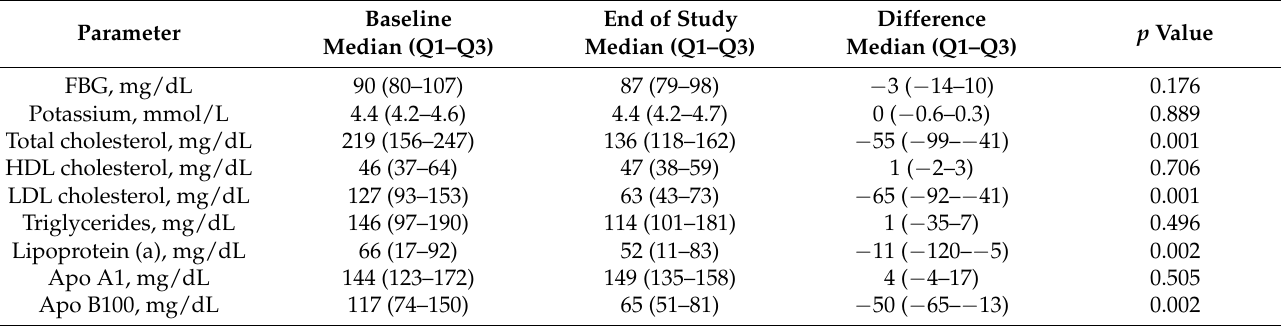
Table 2. Blood biochemistry data of the study